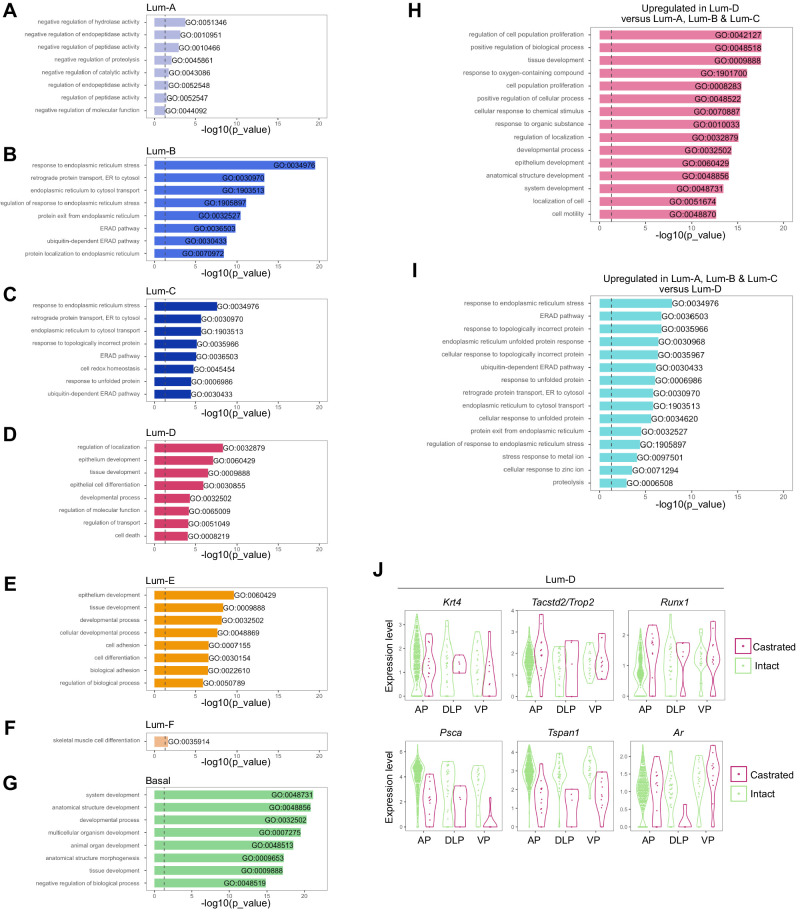
Gene Ontology and differential expression analysis within the scRNA-seq prostate epithelial dataset.Bar plots of the eight most significantly (g:Profiler adjusted p-value<0.05) enriched gene ontology (GO) terms (GO:BP, Biological Processes) using the list of differentially upregulated genes specific to (A) Lum-A, (B) Lum-B, (C) Lum-C, (D) Lum-D, (E) Lum-E, (F) Lum-F, and (G) Basal clusters. (H, I) Fifteen most enriched GO terms (g:Profiler adjusted p-value<0.05) for genes upregulated in the Lum-D cluster against combined Lum-A, Lum-B, and Lum-C clusters in H. Results of the opposite comparison are shown in I. (J) Violin plots showing the expression levels of specific genes within the Lum-D cluster. Data are split and colored by treatment for each lobe. The expression of Krt4, Tacstd2/Trop2 and Runx1 does not vary upon treatment, while Androgen Receptor (AR) regulated genes such as Psca and Tspan1 are downregulated after castration.